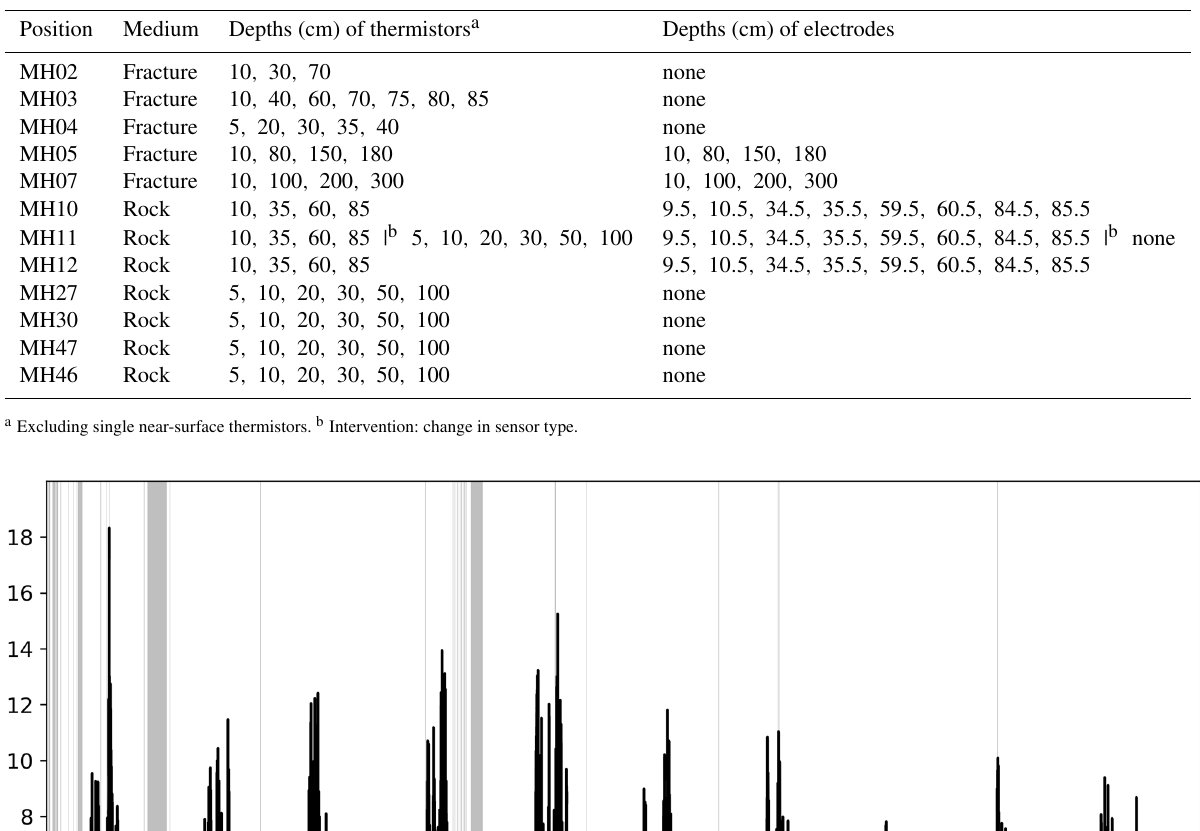
Table 3. Depths of thermistors and electrodes by position and medium under investigation.